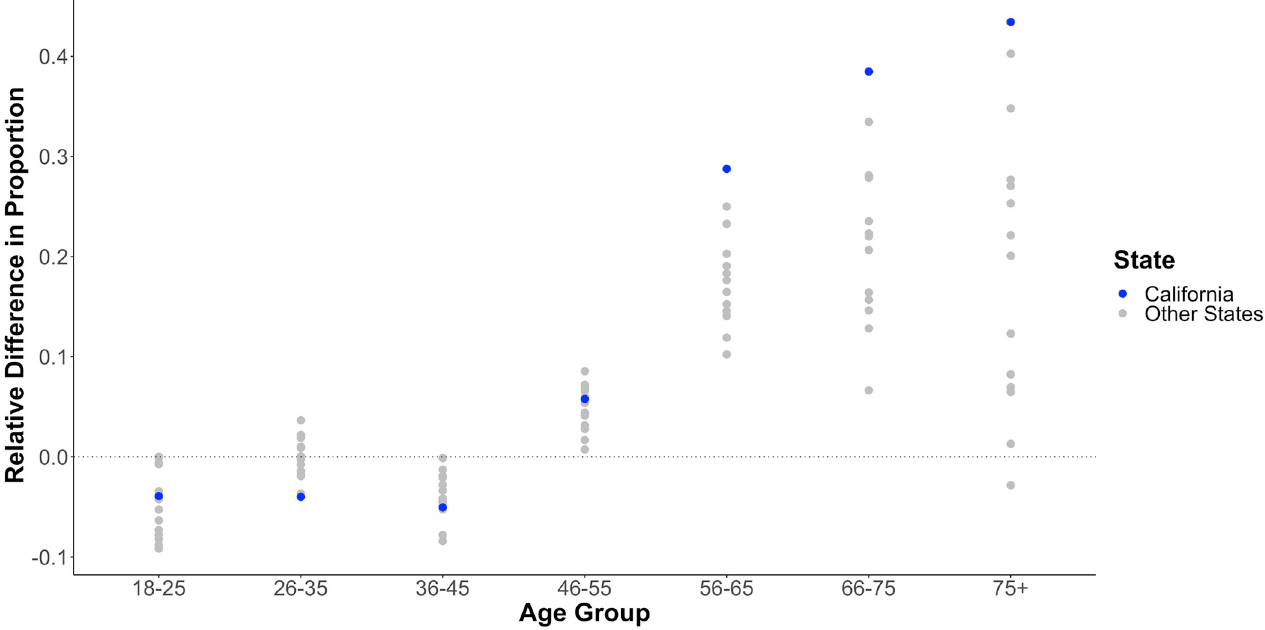
Fig 3. Relative change in proportion of person time by age group for 17 states with reliable National Corrections Reporting program data, 2010 to